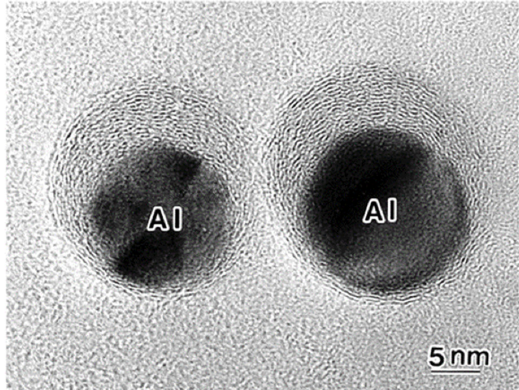
Figure 10. Giant onion-like fullerenes induced under Al nanoparticles by electron irradiation at an intensity of 3.0 × 10 19 e/cm 2 s for 2050 s. The Al nanoparticles are surrounded by onion-like fullerene shells [10].